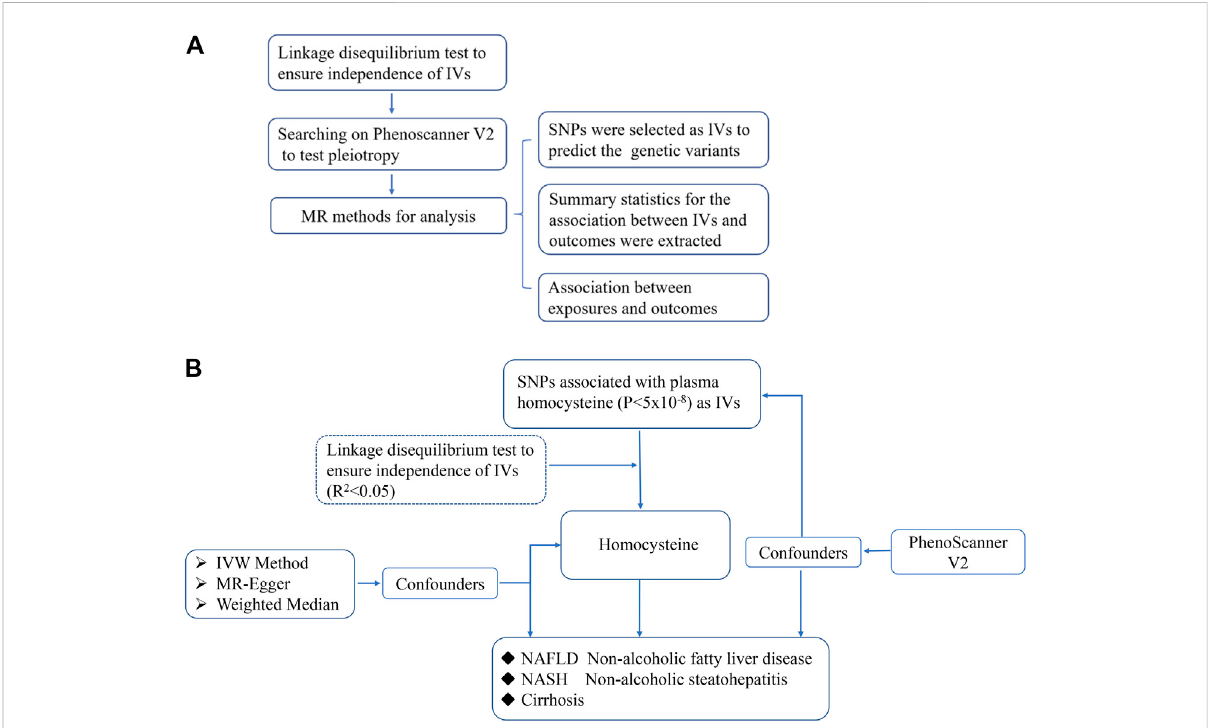
FIGURE 1 The scienti fi c procedure of Mendelian Randomization analysis. (A) . The work fl ow to compute the relationship of IVs and outcomes in MR; (B) . Thebrief fl owchartanalysisofserumlevelsofhomocysteineandriskofNAFLD,NASHandCirrhosis,andNASHandCirrhosisaremoresevereformof non-alcoholic fatty liver in progression.